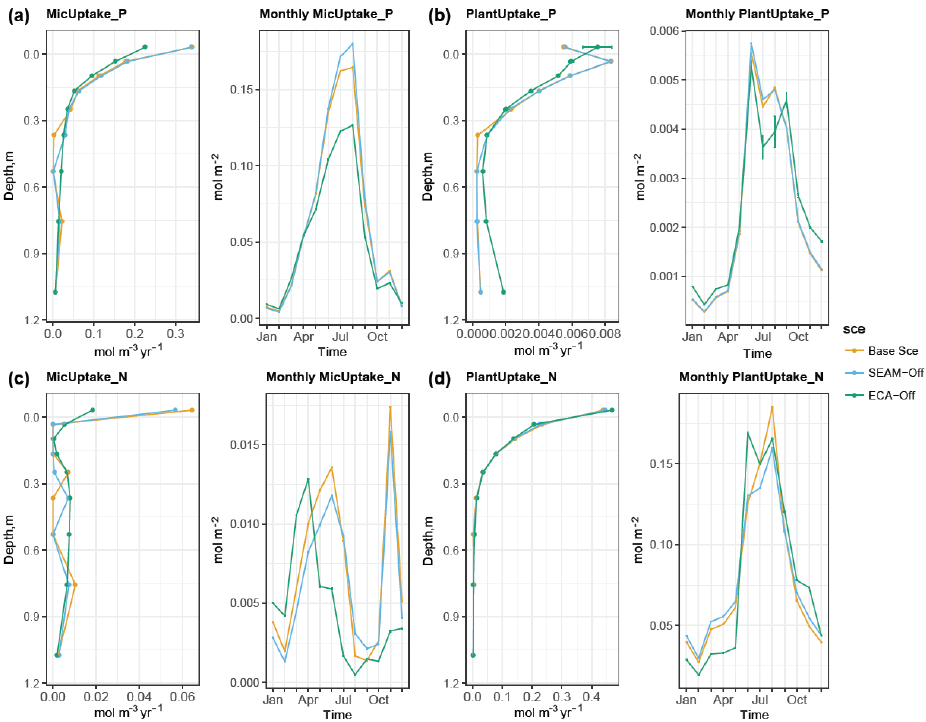
Figure 6. Simulated seasonal and vertical distribution of (a) microbial inorganic P uptake, (b) plant P uptake, (c) microbial inorganic N uptake and (d) plant N uptake at the study site at 1m soil depth. Points represent the mean values and error bars represent the standard deviations, both calculated using data from the last 10 years of model